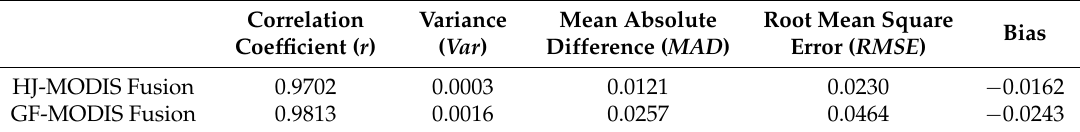
Table 5. Results of the correlation analysis between synthetic and actual HJ, GF NDVI data. Correlation Variance Mean Absolute Root Mean Square Bias Coefficient ( r ) ( Var ) Difference ( MAD ) Error ( RMSE ) HJ-MODIS Fusion 0.9702 0.0003 0.0121 0.0230 ´ 0.0162 GF-MODIS Fusion 0.9813 0.0016 0.0257 0.0464 ´